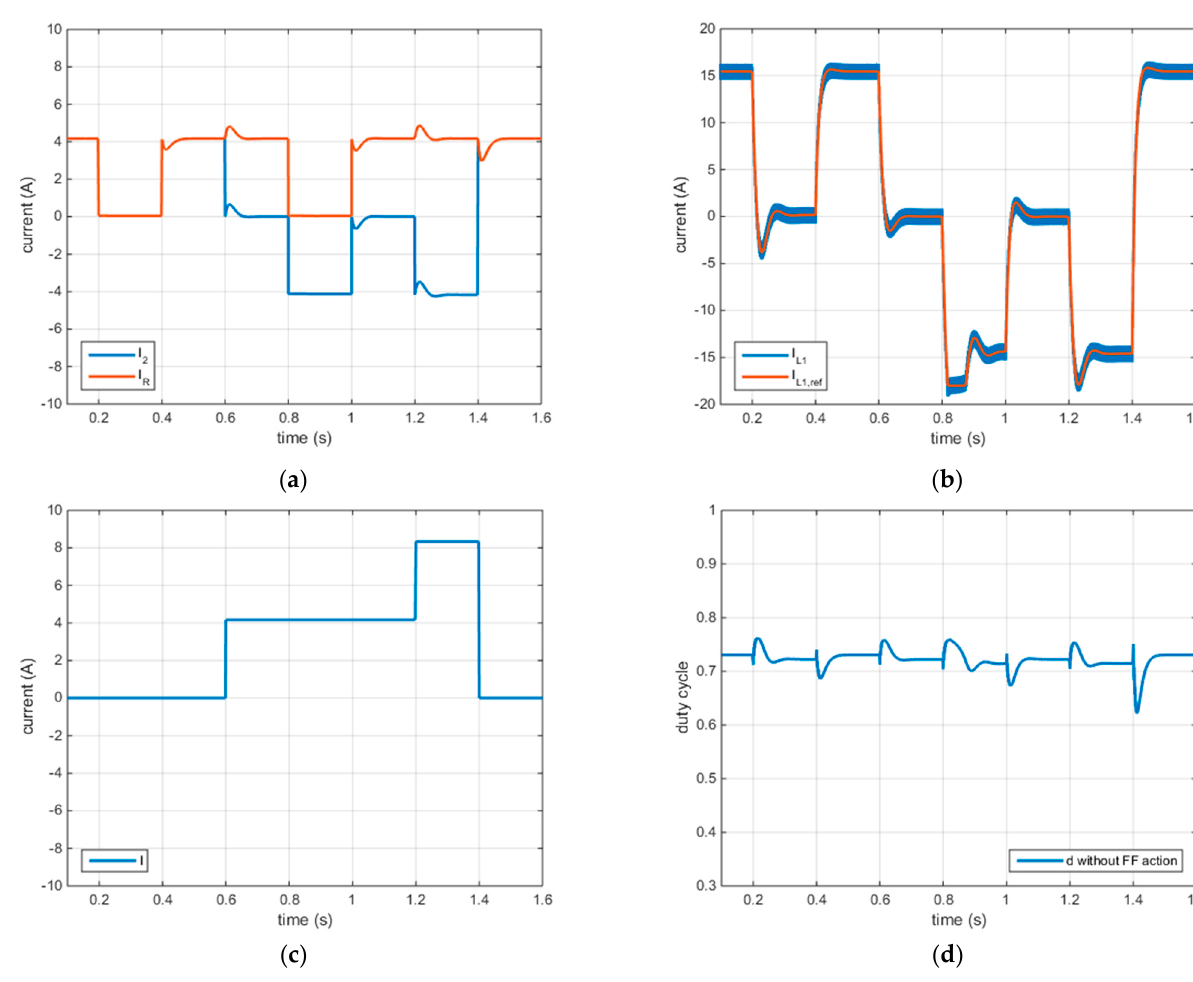
Figure 2. Baseline performance without FF action: ( a ) output current and load current; ( b ) input inductor current; ( c ) external generator’s current; ( d ) duty cycle. Table 3. Transitions considered in the baseline scenario and scenarios #1 (SS-GN) and #2 (SD-GN).